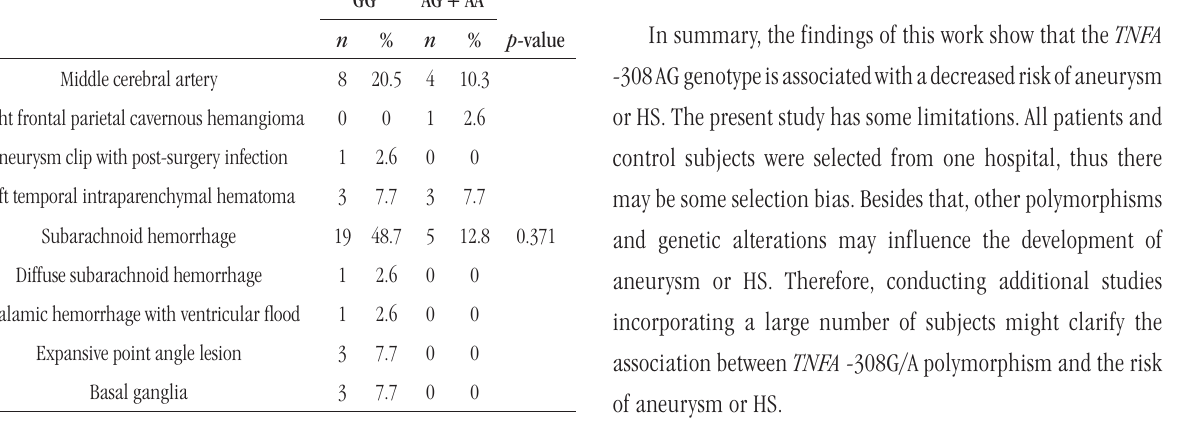
Middle cerebral artery